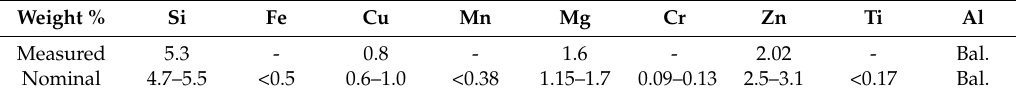
Figure 4. Energy Dispersive X-ray spectroscopy (EDX) lines of ( a ) Si ( b ) Zn and ( c ) Mg. Table 3. Measured and nominal composition of a 50% 7075 sample built with the optimized